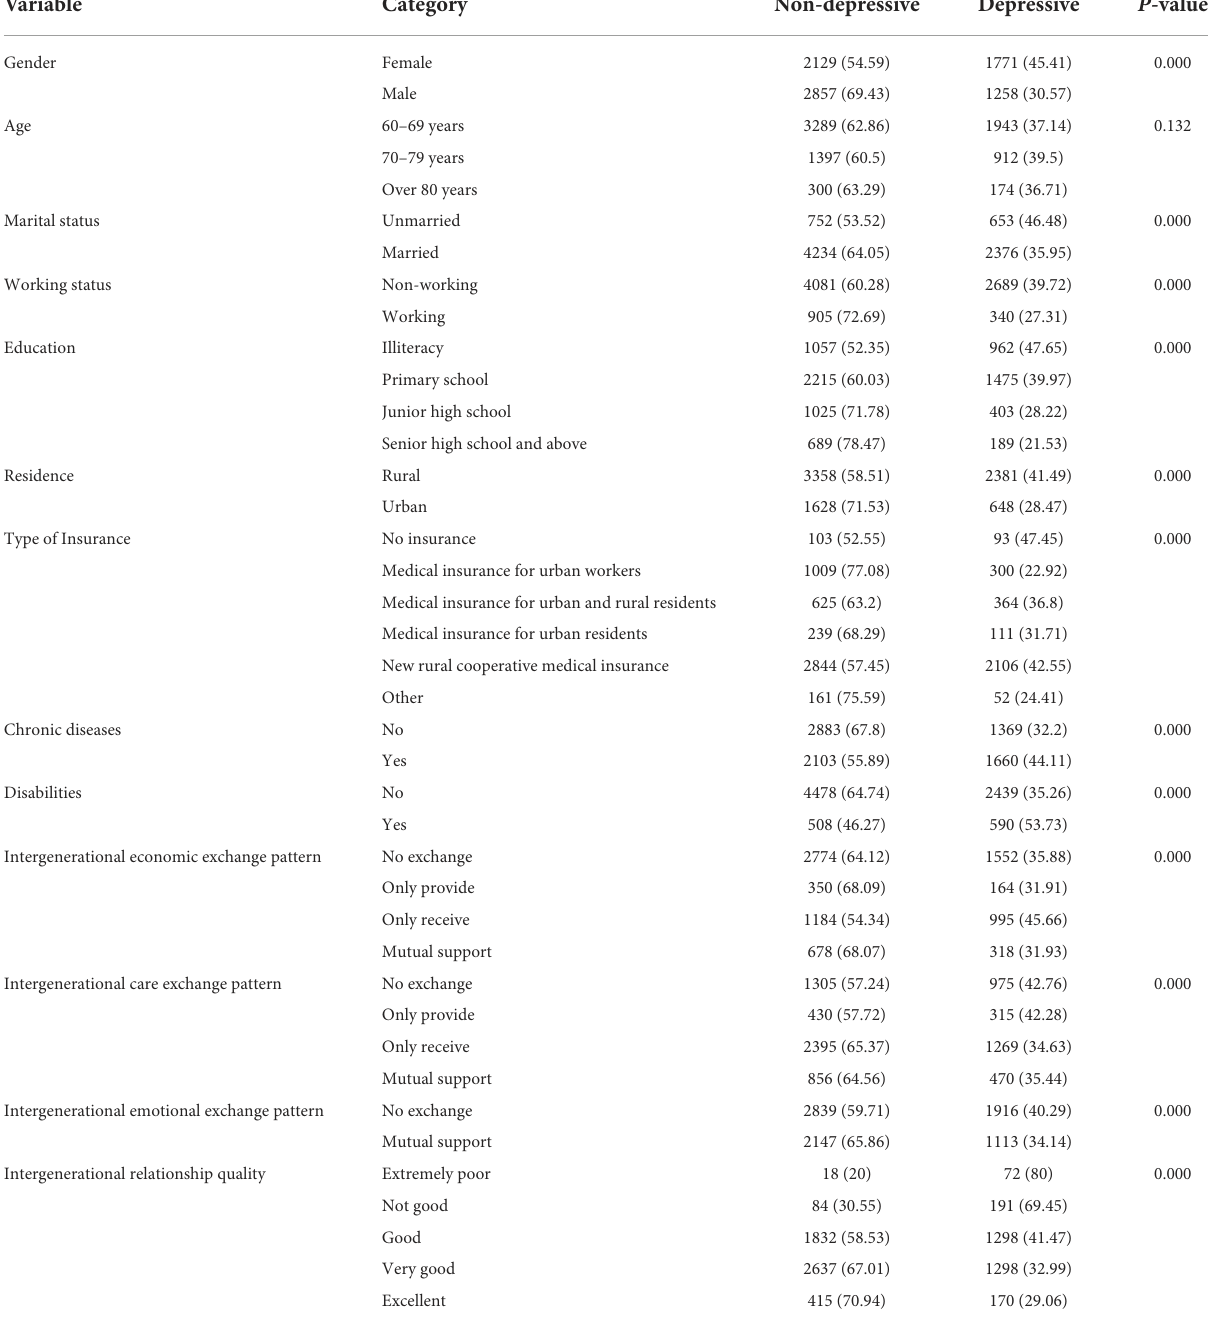
TABLE 5 Correlation analysis on the influencing factors of depressive symptoms ( n = 8,015, n /%).